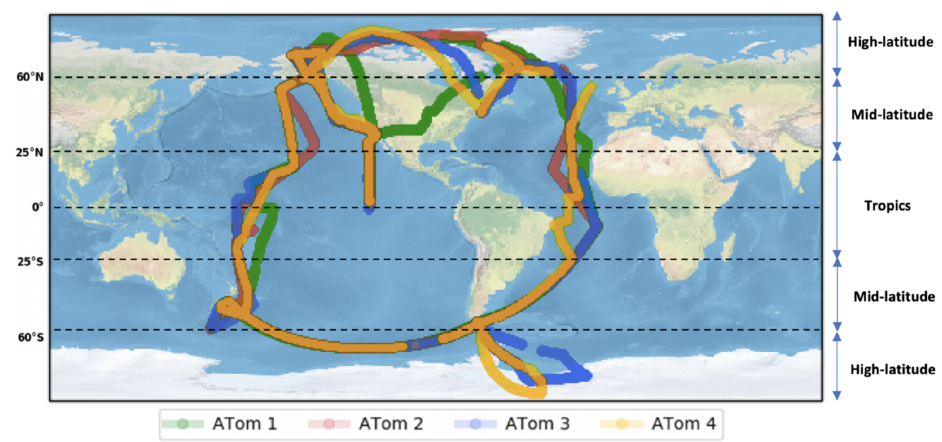
Figure 1. Flight tracks for NASA DC-8 for the four ATom campaigns: ATom1 (August–September 2016, green), ATom2 (January– February 2017, red), ATom3 (September–October 2017, blue) and ATom4 (April–May 2018,